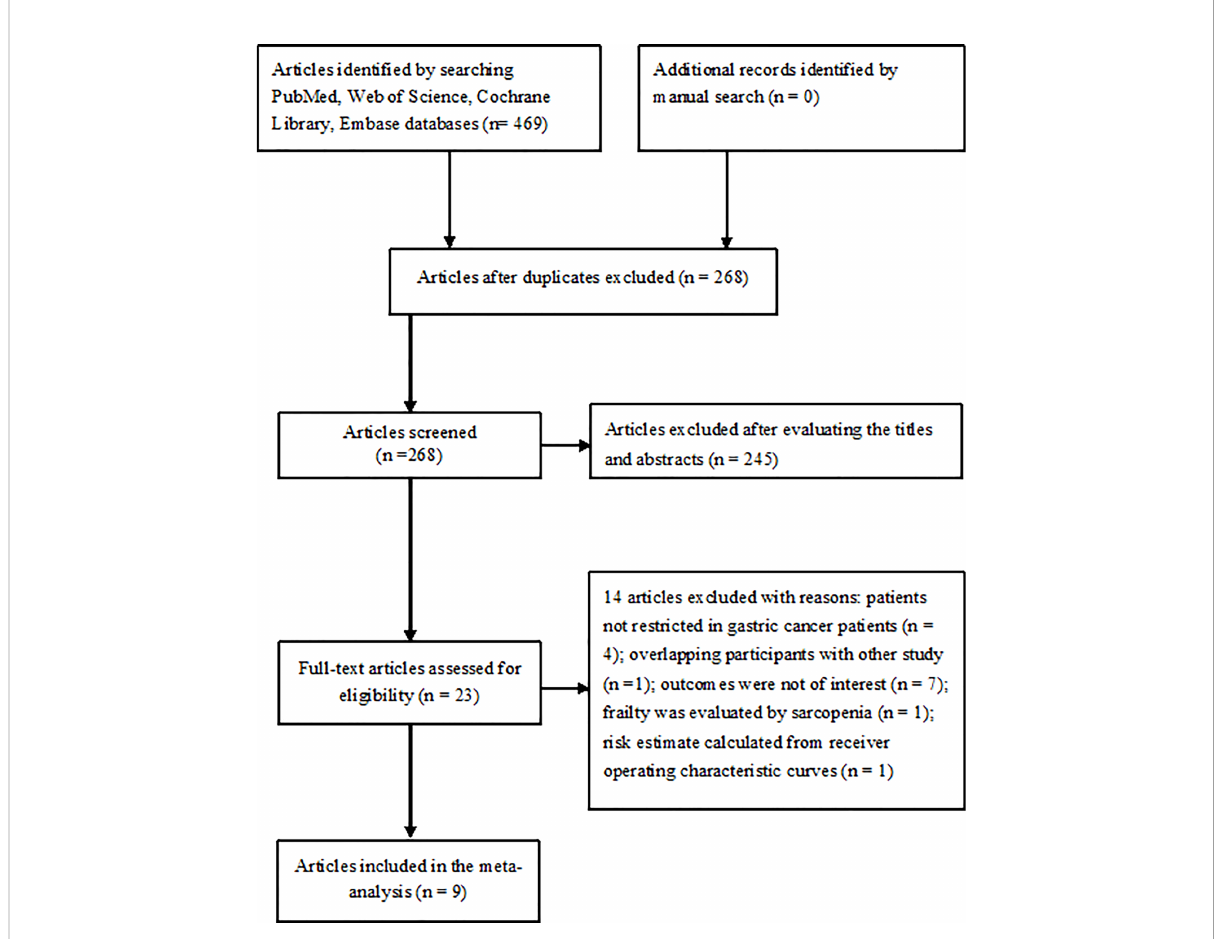
FIGURE 1 Flowchart showing the process of study